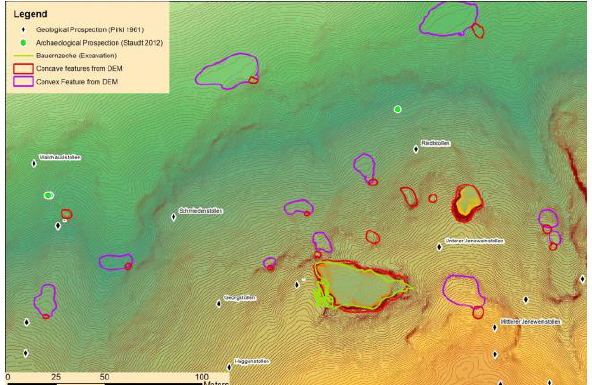
Figure 6. Information sources that indicate physical structures